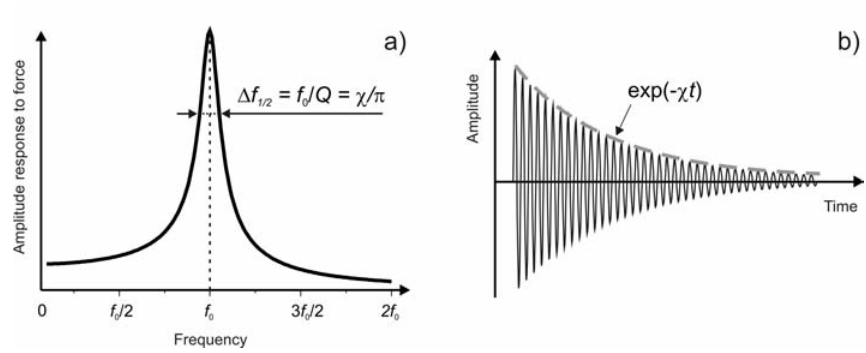
Figure 2. Definition of the attenuation coefficient, | , and the quality factor, Q , for an oscillatory process in (a) the frequency-domain, and (b) the time- domain. In a steady-state oscillation, the attenuation coefficient measures the width of the resonance peak at 1/ of the maximum amplitude, and Q = | / r = f / Q . An example with Q = 10 is shown. measures its relative width: D f 1/2 0